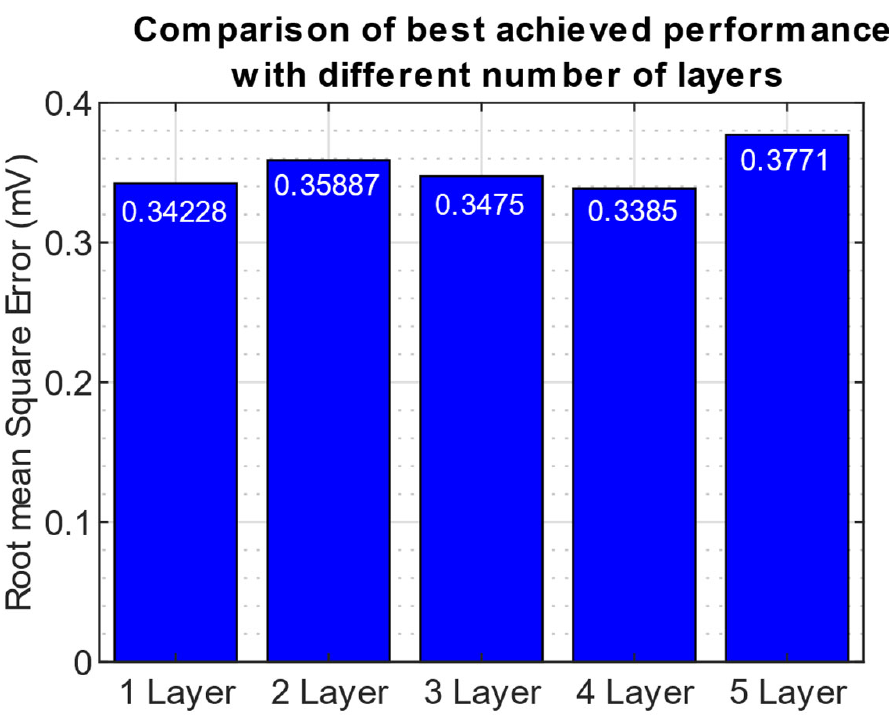
Figure 3. Final Test Set RMSE values for the optimal models found using BOpt. We observed that the 4-layer network had the lowest test set RMSE value (0.3385 mV). The difference between the best and worst RMSE is ~40 µ V. The hyper- parameters associated with the optimal model are in Table